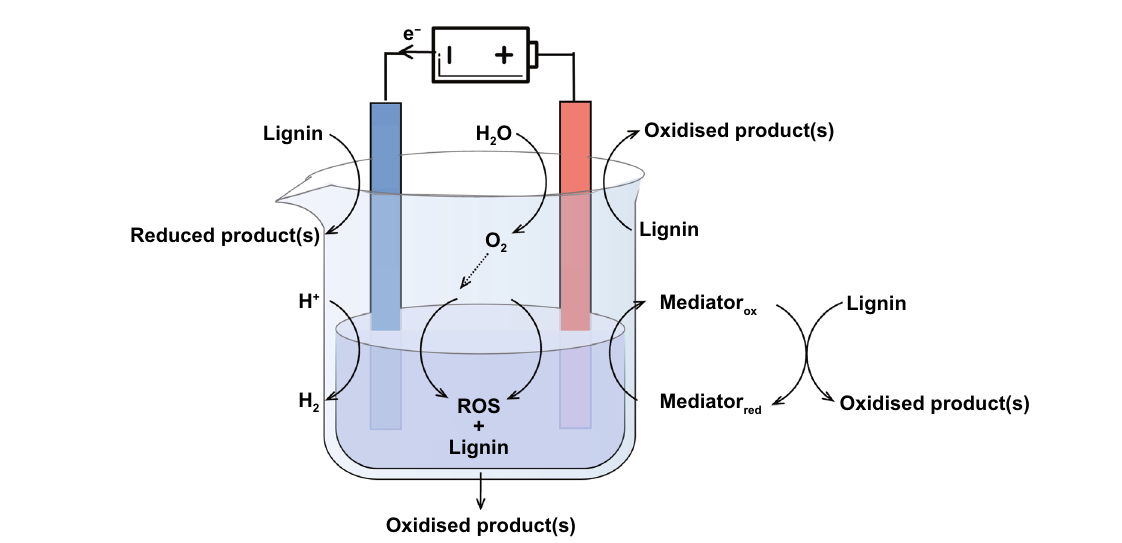
Fig. 7 Electrochemical lignin valorization. Electro-oxidation at the anode via direct, mediated methods and via the generation of reactive oxy- gen species (ROS) from reduction of O 2 . Electroreduction via direct method. Water splitting competes with lignin electrochemical conversion at both anode (OER) and cathode (HER)